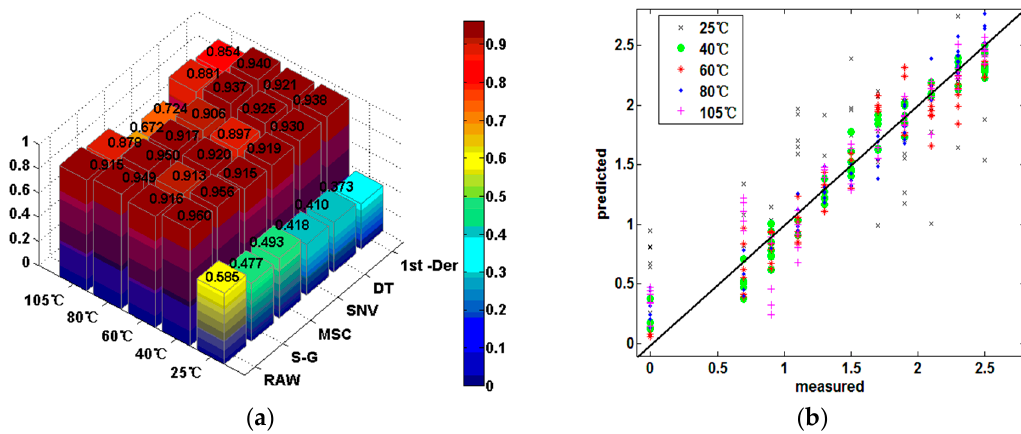
Figure 3. ( a ) The determination coefficients of the partial least squares (PLS) method after different spectral pretreatments; ( b ) the prediction results of the RAW-PLS model at different temperatures.